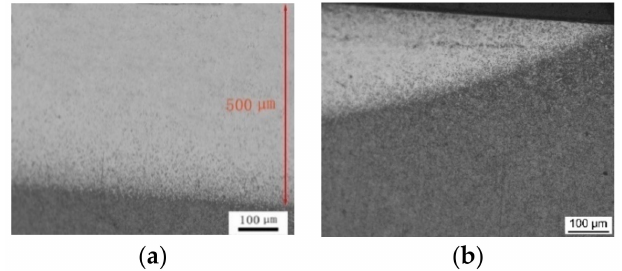
Figure 6. Metallographic cross-section of laser hardened layer with a scanning speed of 800 mm/min; ( a ) thickness of middle position and ( b ) crescent shape on right